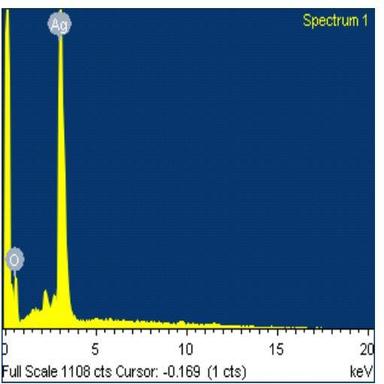
EDS spectra of Moringa oleifere leaf Extract